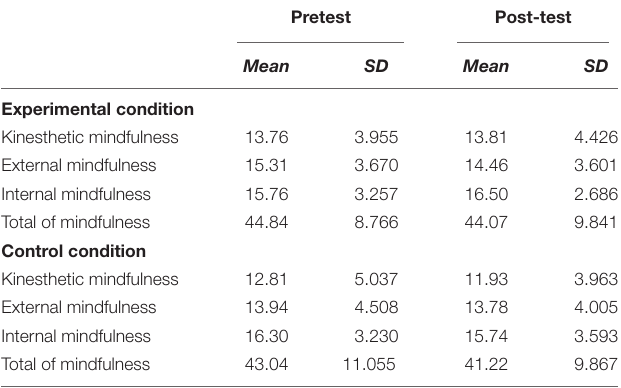
TABLE 3 | Descriptive statistics scores.